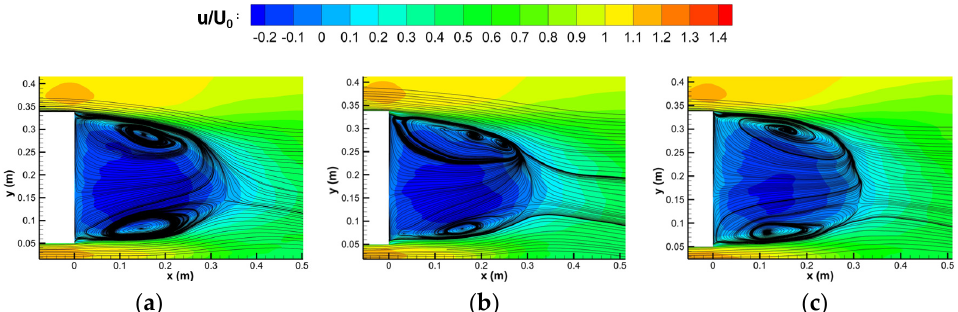
Figure 18. Time-averaged streamlines in the behind of the model, on the symmetry plane with a synthetic jet at different jet angles. ( a ) β = 30 ◦ ; ( b ) β = 60 ◦ ; ( c ) β = 90 ◦ .